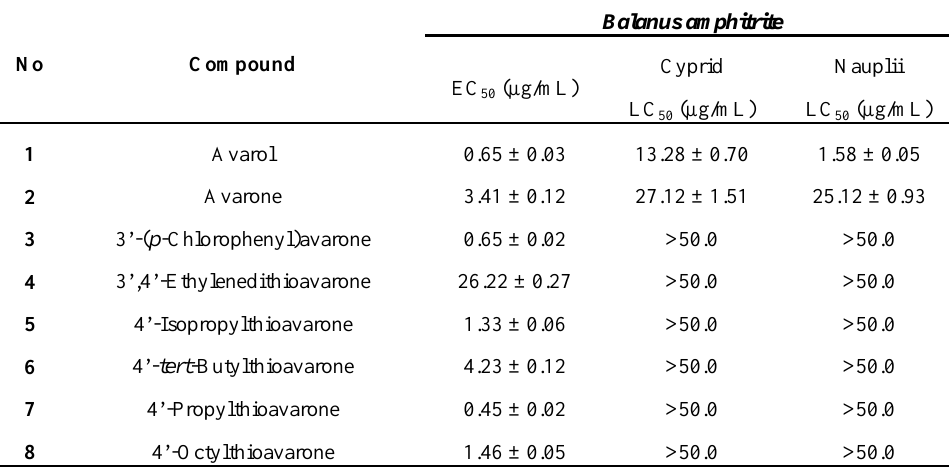
Table 3. Evaluation of anti-settlement and toxicity of compounds 1 - 8 on B. amphitrite .